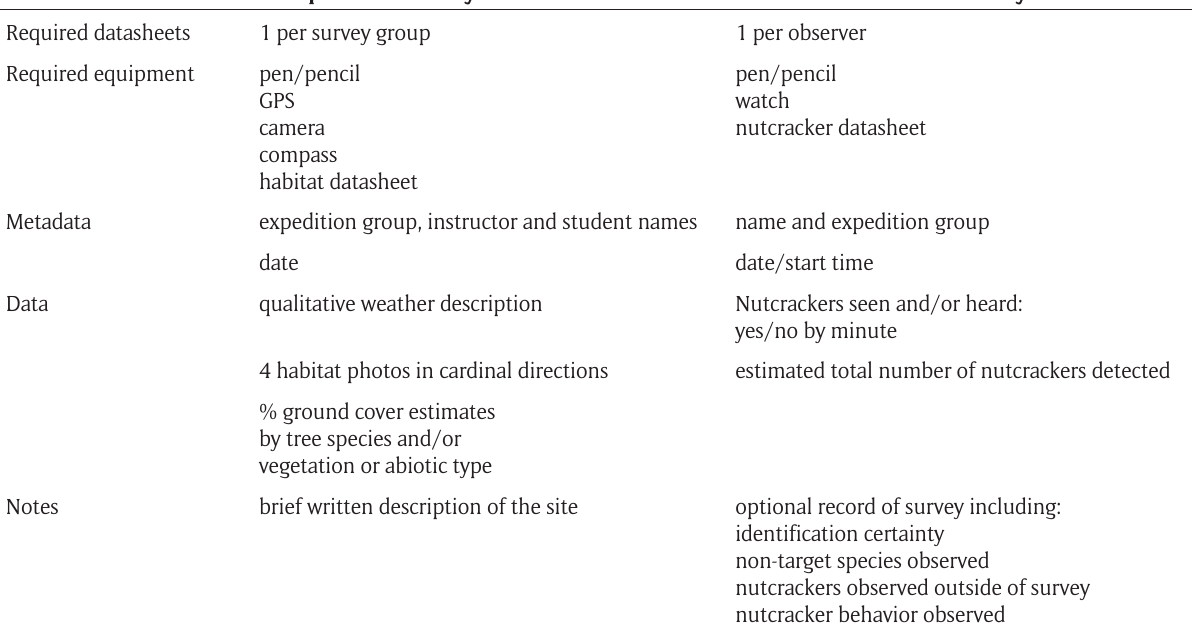
Table 1: Clark’s Nutcracker Project data collection